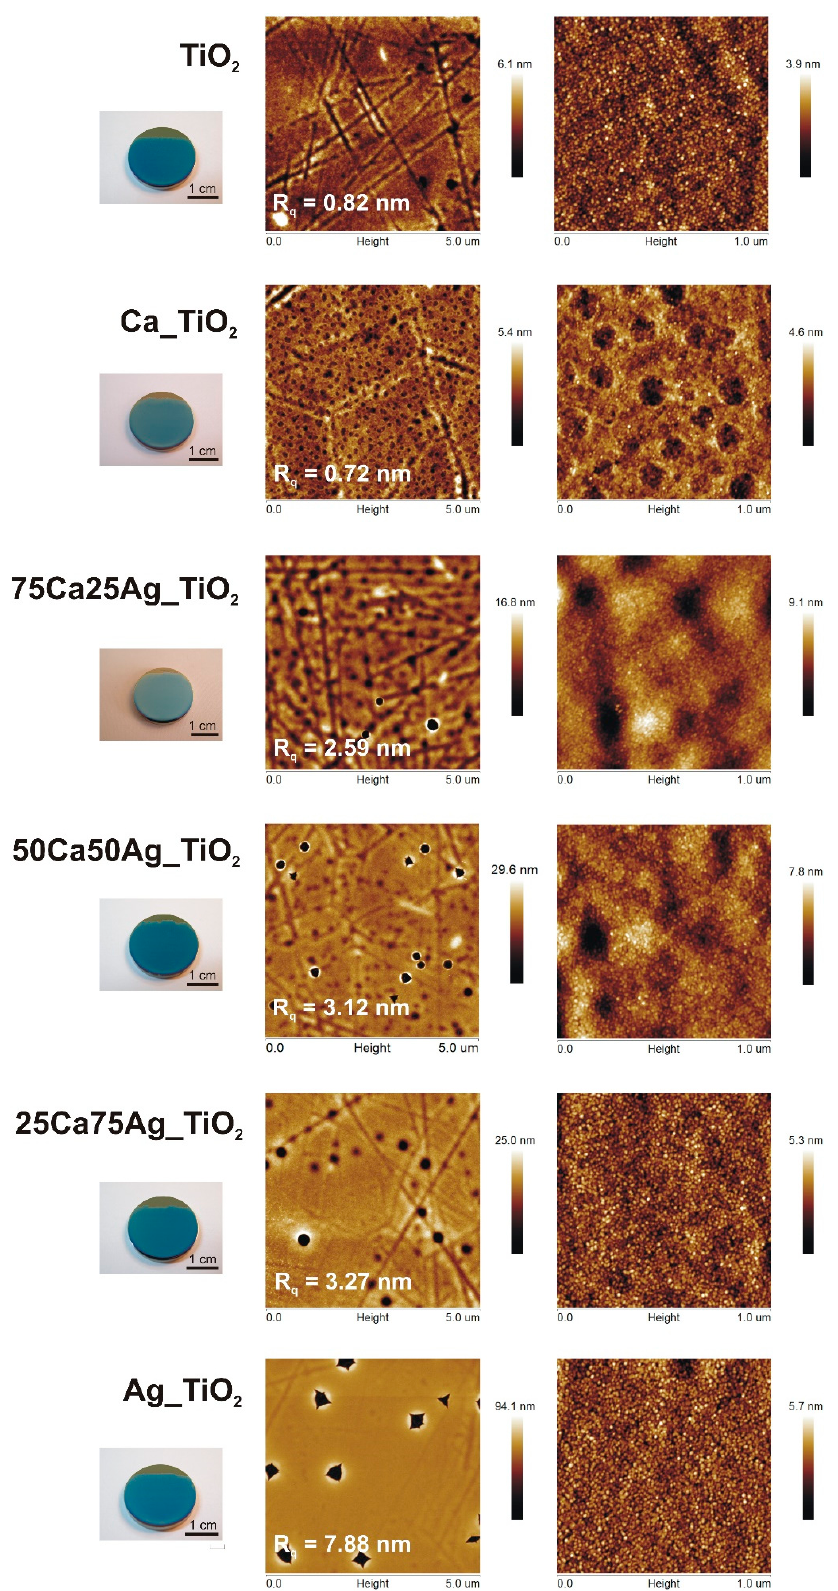
Figure 1. The general view of the coated samples, and atomic force microscopy (AFM) images (scan sizes of 5 μ m × 5 μ m and 1 μ m × 1 μ m) for all types of coatings.